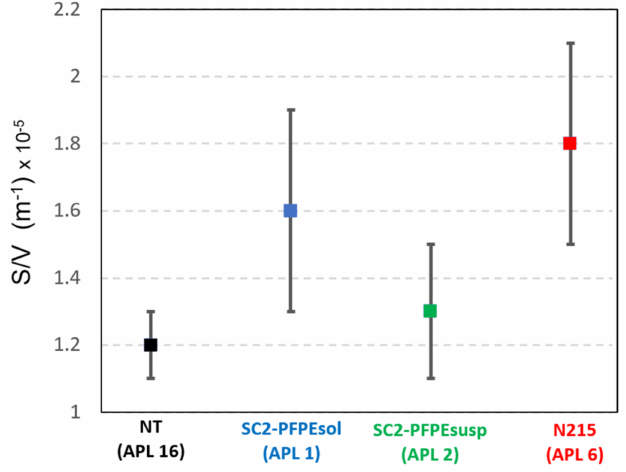
Figure 11. Estimation of the average S/V through the diffusion coefficient method for uncoated and coated Lecce stone specimens.